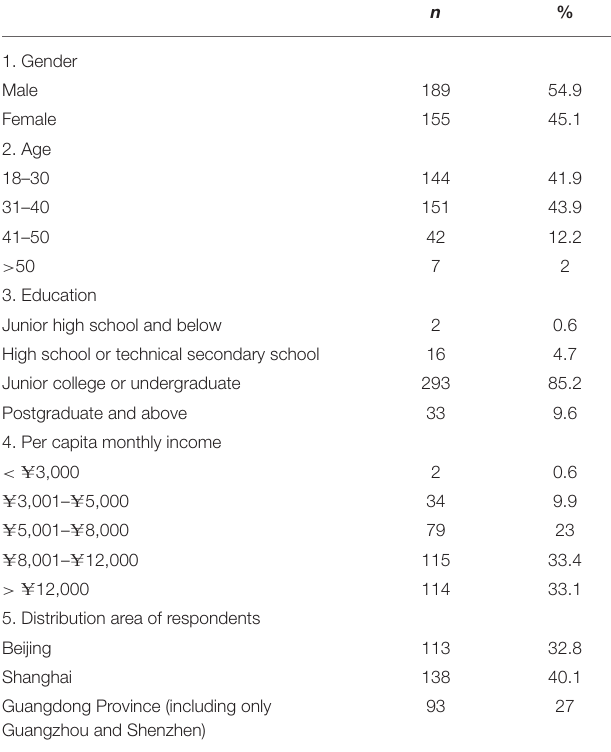
TABLE 1 | Demographic profile of the sample ( N =